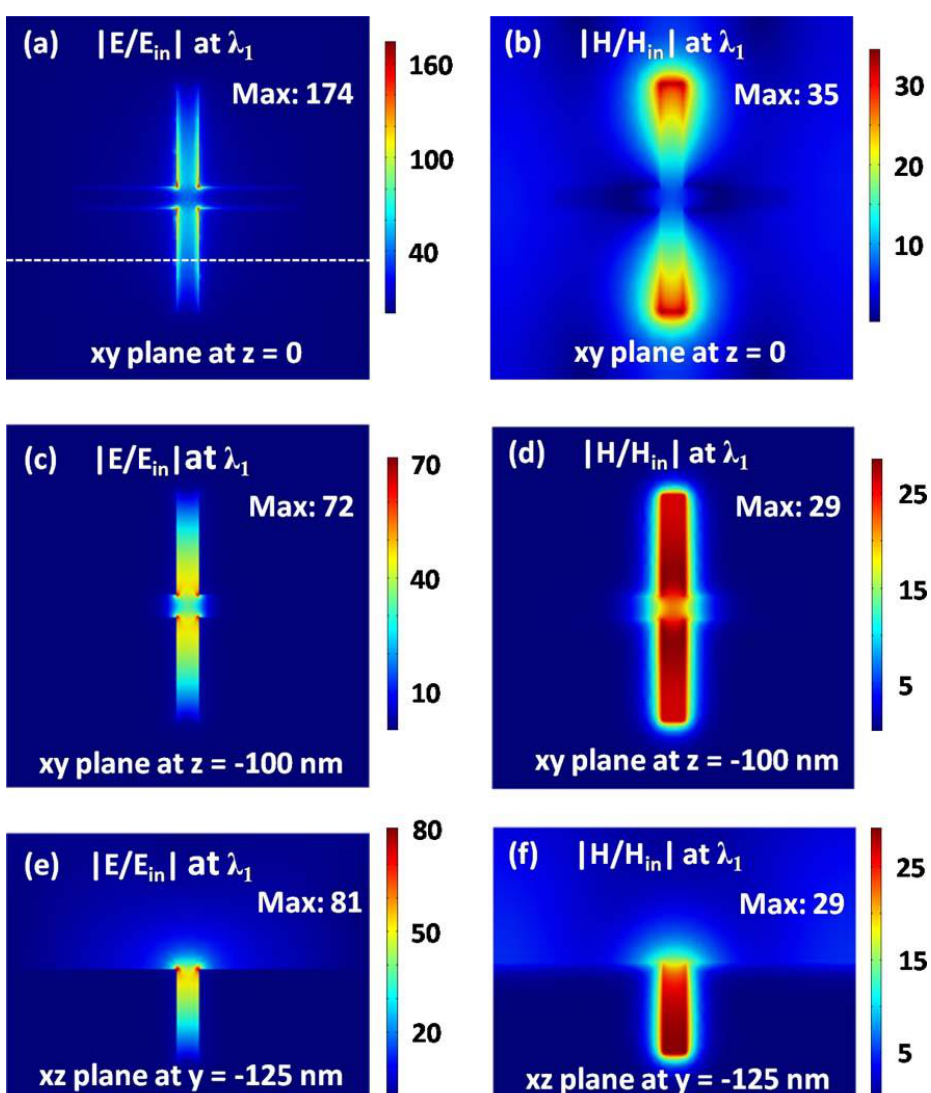
Figure 3. Electric ( a , c , e ) and magnetic ( b , d , f ) field strength at the resonance wavelength of λ 1 . The xy plane with z = 0 ( a , b ) is just on the top surface of the metal substrate. The xy plane with z = −100 nm ( c , d ) is at the geometrical center of the cross-shaped hole. The xz plane with y = −125 nm ( e , f ) is along the white dotted line in ( a ).